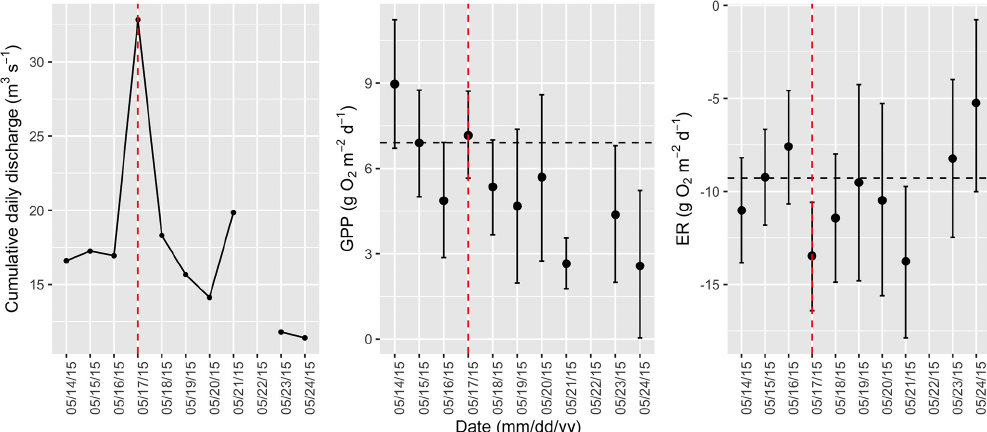
Figure A9. Cumulative daily discharge and metabolism (gross primary production and ecosystem respiration; GPP and ER) time series for the Stroubles Creek flow event on 17 May 2015 (noted with a dashed vertical red line in all three panels). The dashed horizontal black lines are mean values of GPP and ER prior to the high flow event. Error bars for posterior estimates of GPP and ER are 2.5% and 97.5% Bayesian credible